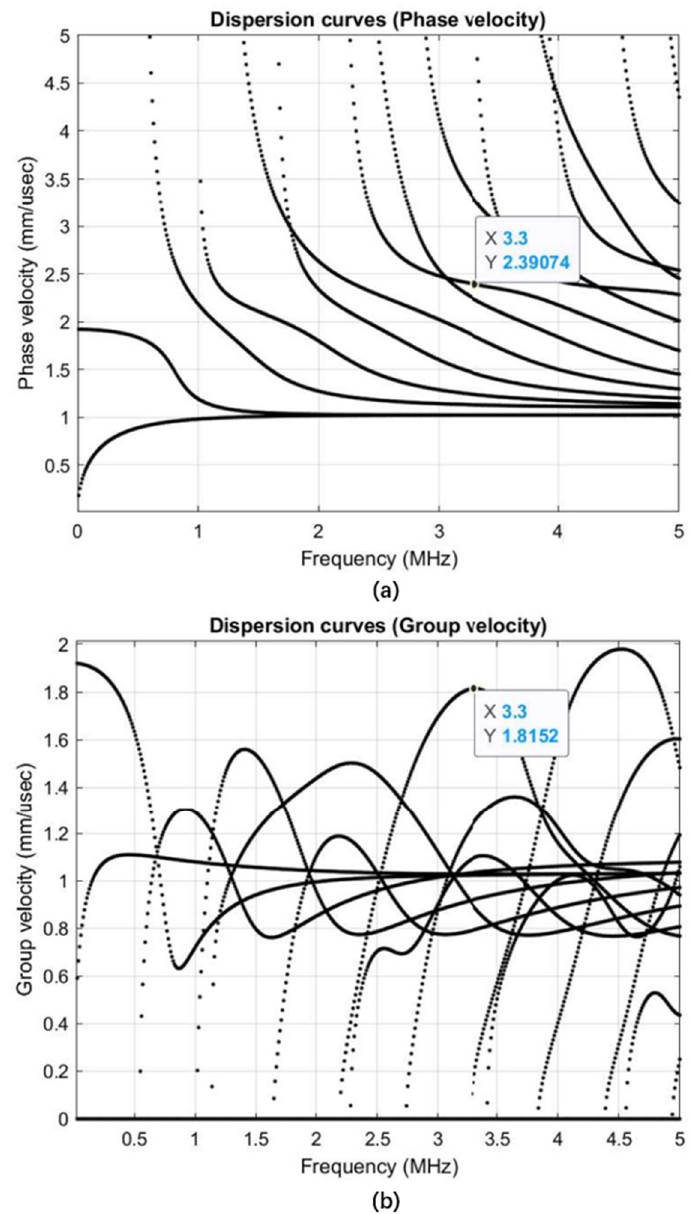
Figure 1. Dispersion curve for coatings specimen. ( a ) Dispersion curve for phase velocity; ( b ) dispersion curve for group velocity.